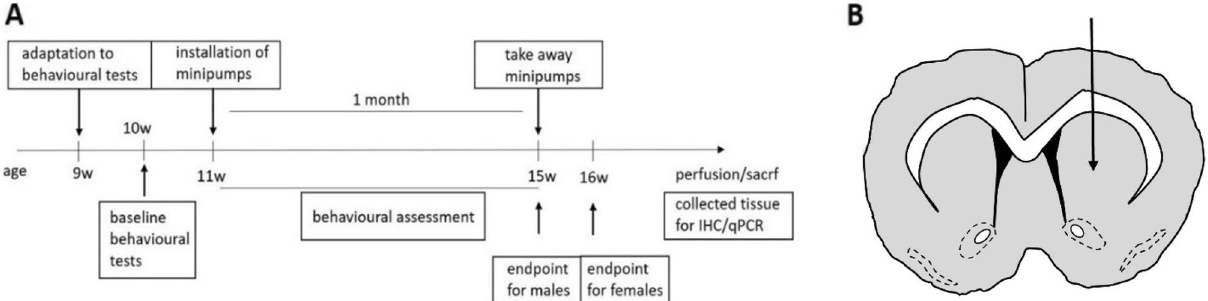
Figure 1. Study design. ( A ) Experimental timeline. An intrastriatally implanted cannula connected to a minipump releasing vehicle (PBS) or CDNF was installed subcutaneously at 11 weeks of age of N171-82Q mice. Minipumps were removed at 15 weeks. Behavioral tests were conducted twice per week. Animals were sacrificed for collecting tissues at 15 weeks of age for N171-82Q male mice and 16 weeks for N1721-82Q female mice. ( B ) Scheme of cannula placement (A/P + 0.86; M/L − 1.8; D/V − 3.0).